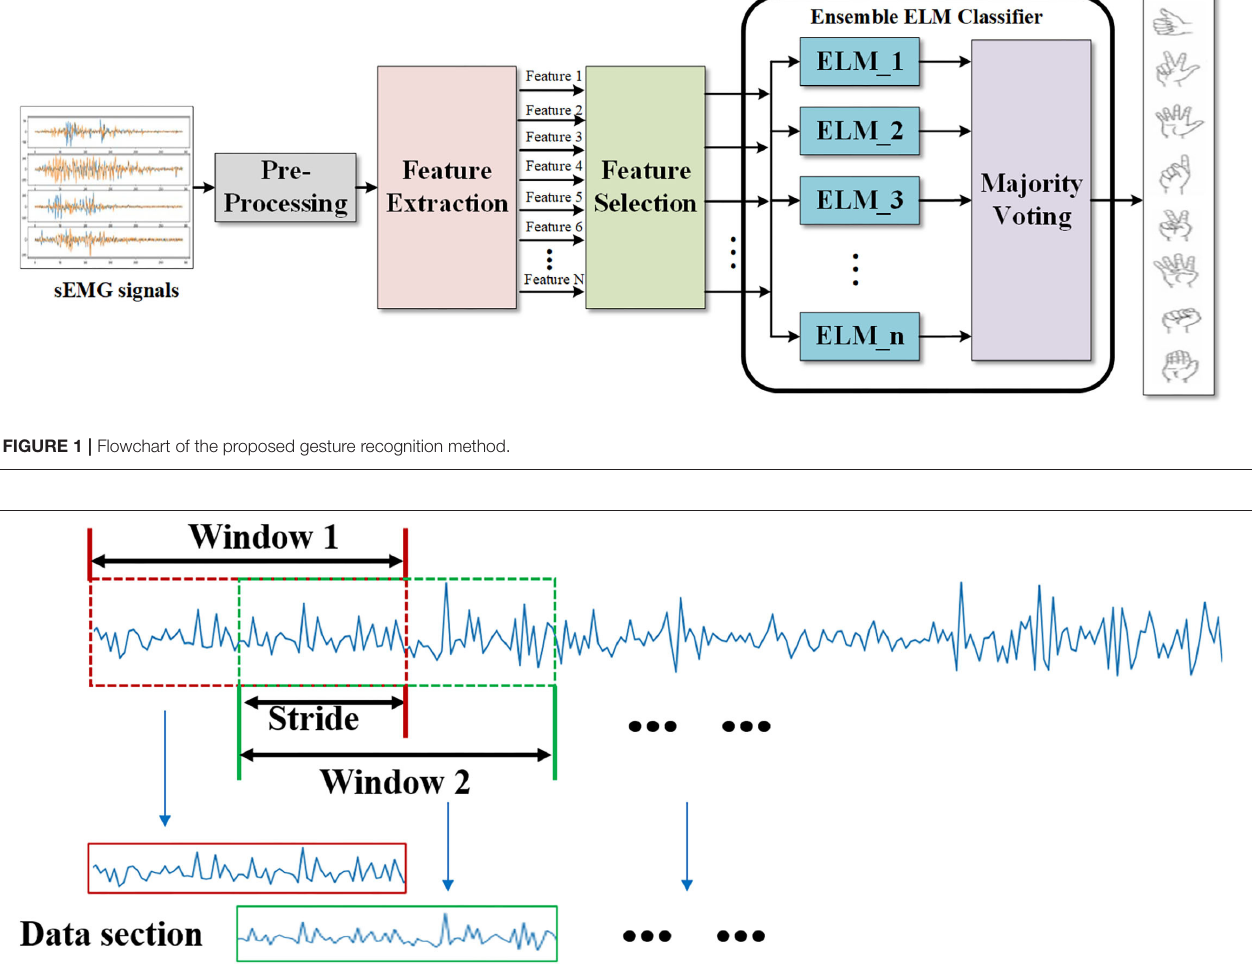
FIGURE 2 | Signal slide window